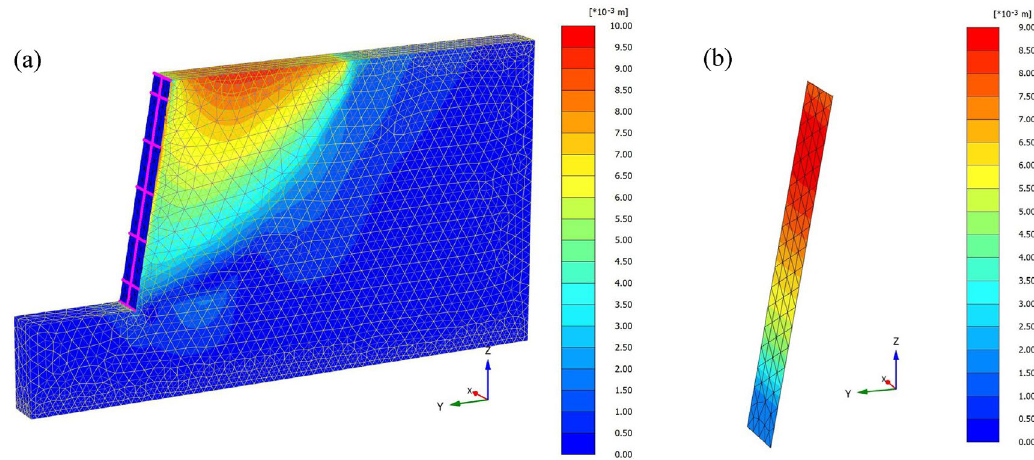
Figure 6. Deformation nephogram of supported slope: ( a ) Slope deformation ( b ) Slope surface